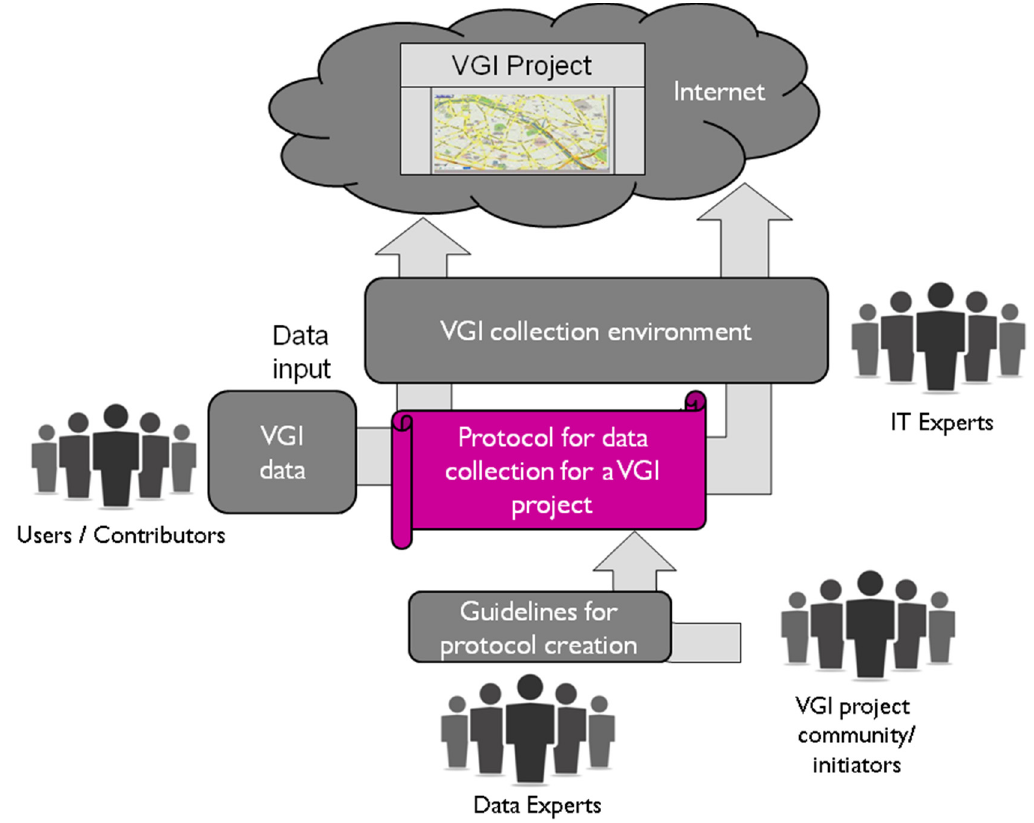
Figure 3. Interaction of the protocol for data collection with the actors involved in the context of a VGI project.